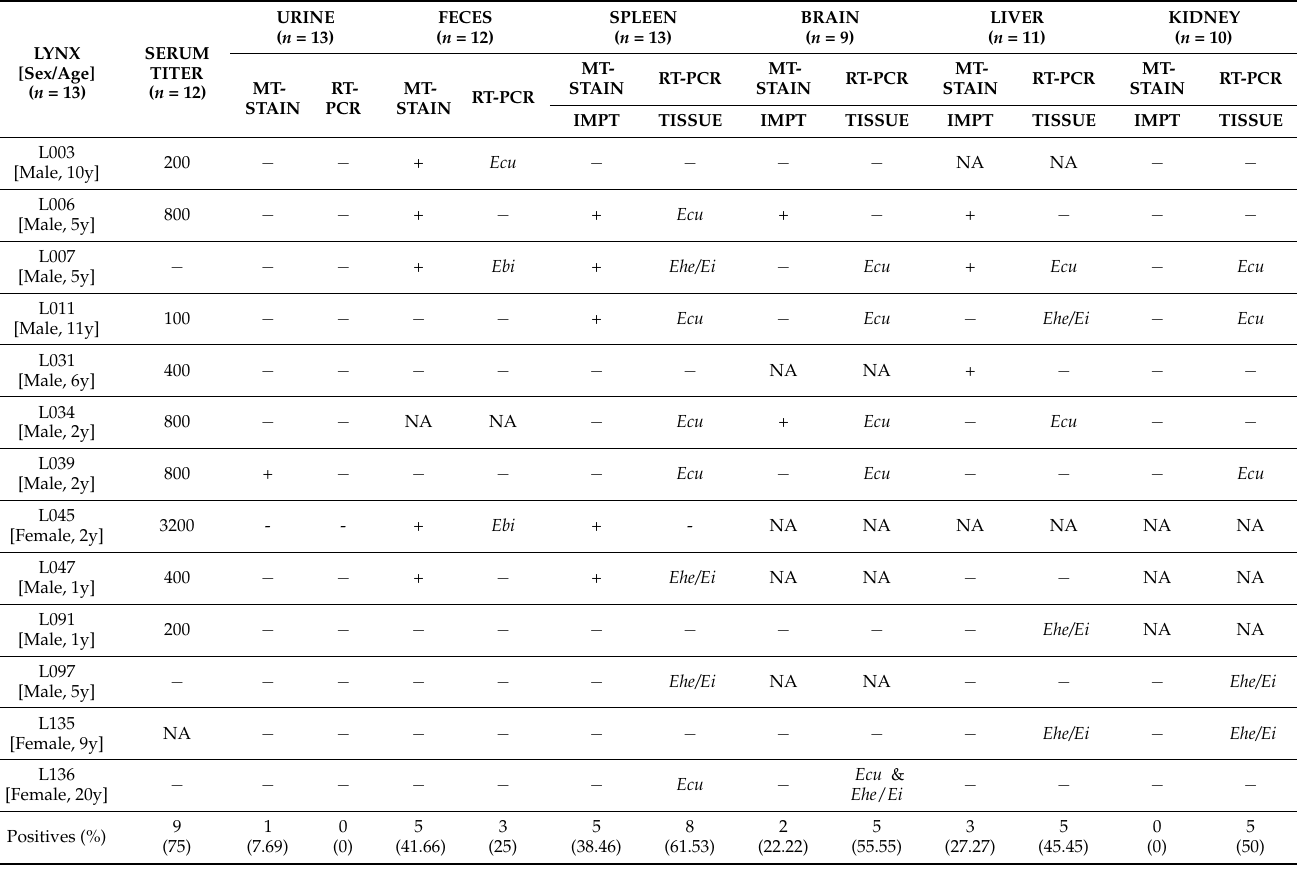
Table 1. Microsporidia analysis of samples from 13 dead lynxes in urinary sediment, feces, and tissues by staining and Real-Time